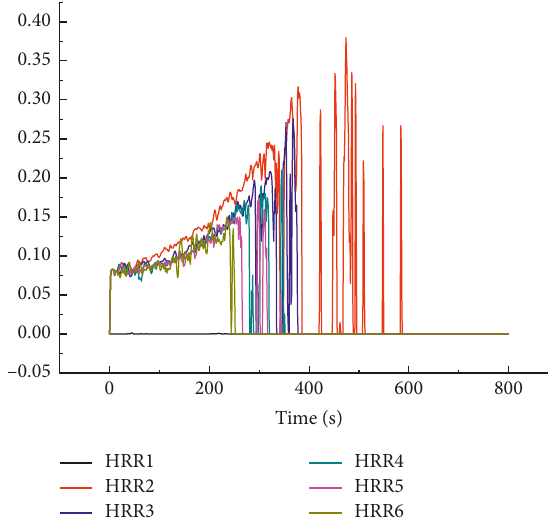
Figure 9: Heat flow density in case 4.